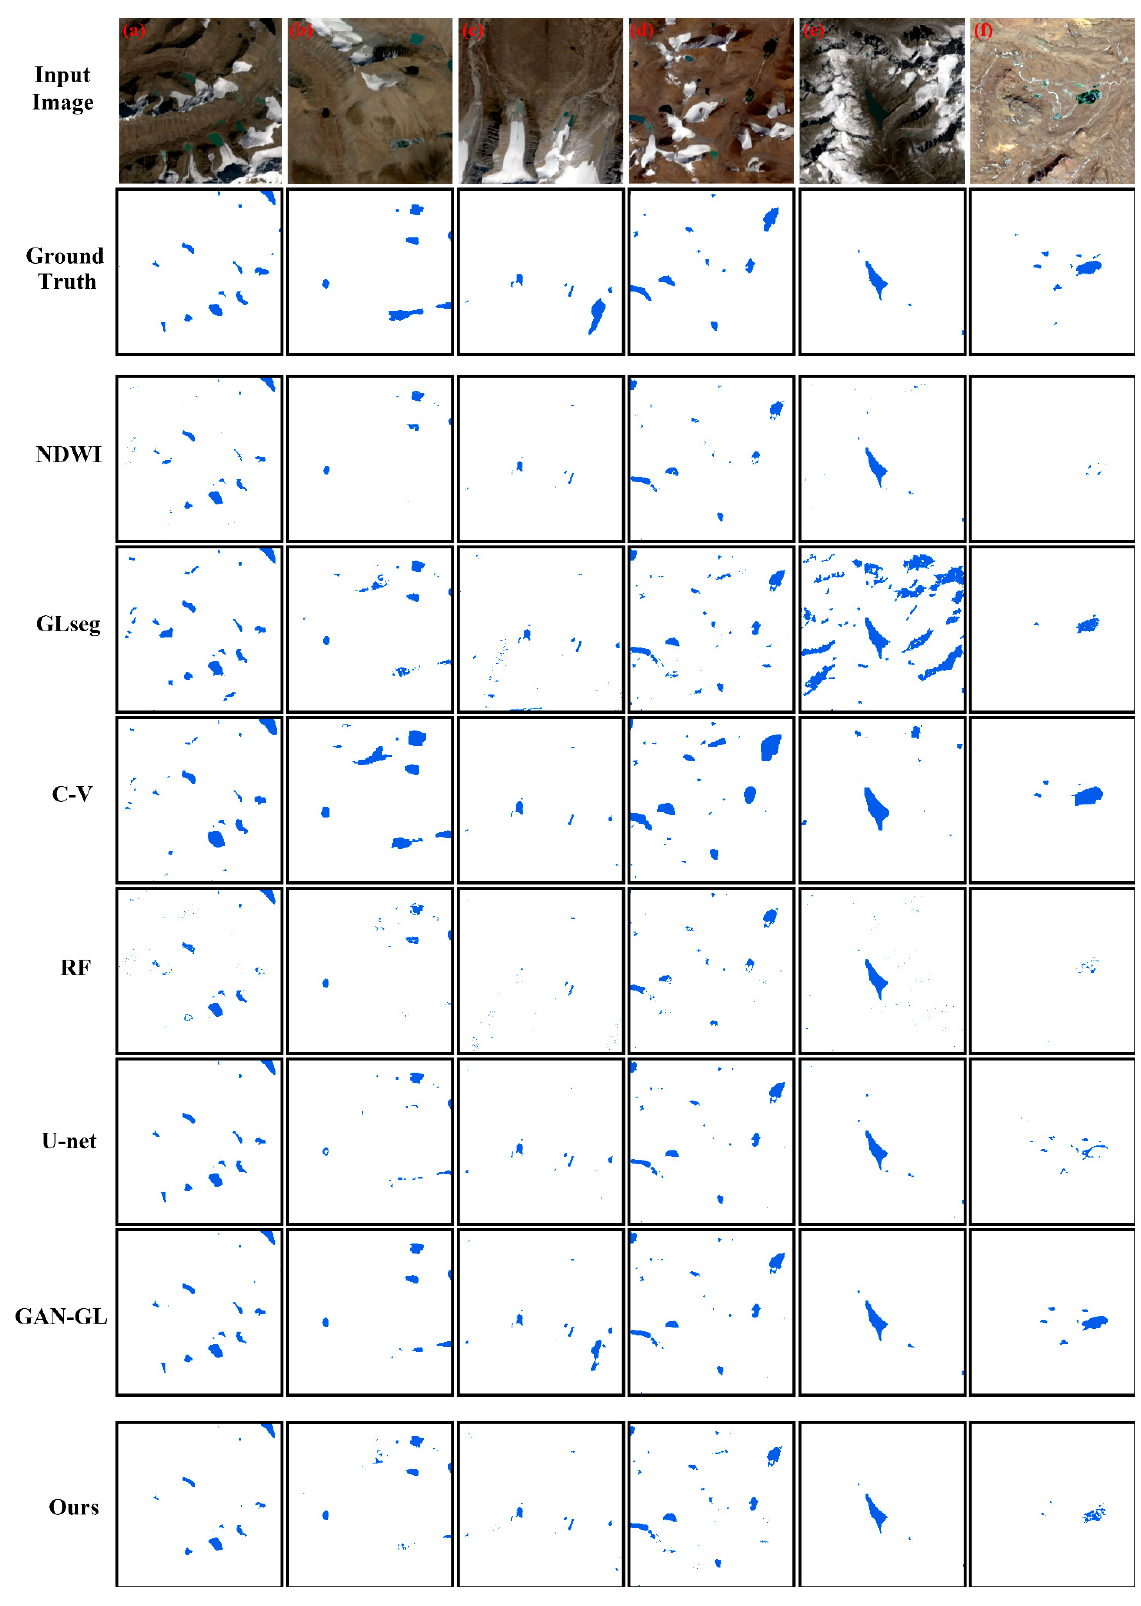
Figure 7. Visualization of segmentation results of the glacial lake by employing different methods. Extracted lakes are marked in blue. ( a – f ) are six regions of glacial lakes developed in different surroundings.